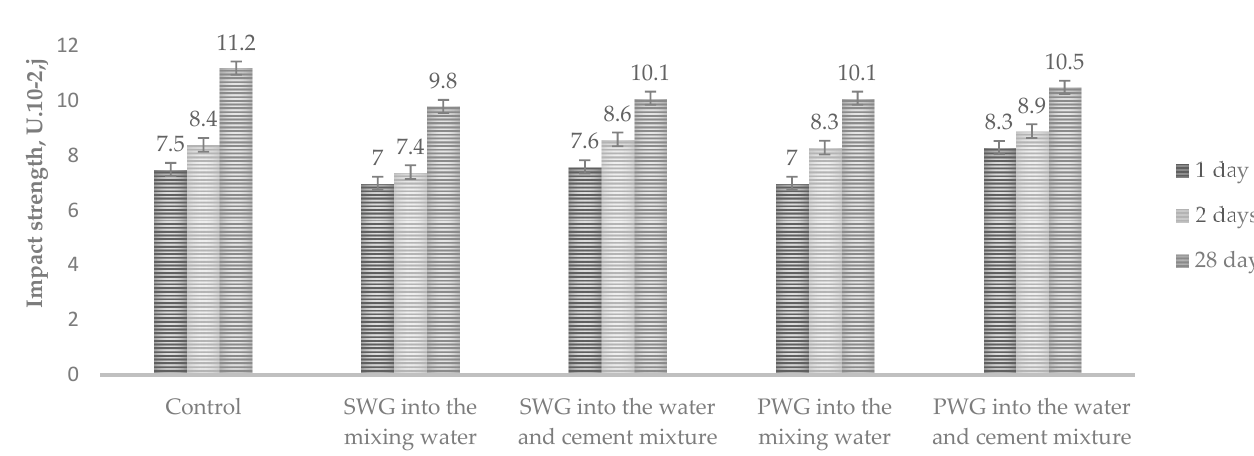
Figure 3. Impact strength depending on the method of WG introduction.